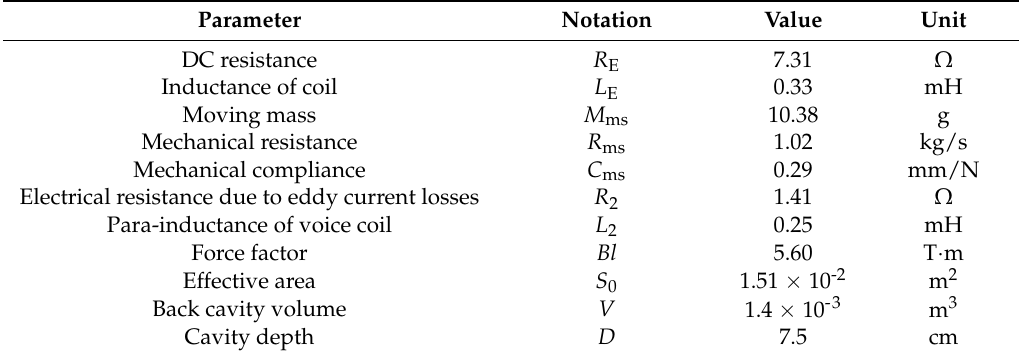
Table 6. Measured TS parameters and dimensions of a closed-box loudspeaker (SL 4 unit).